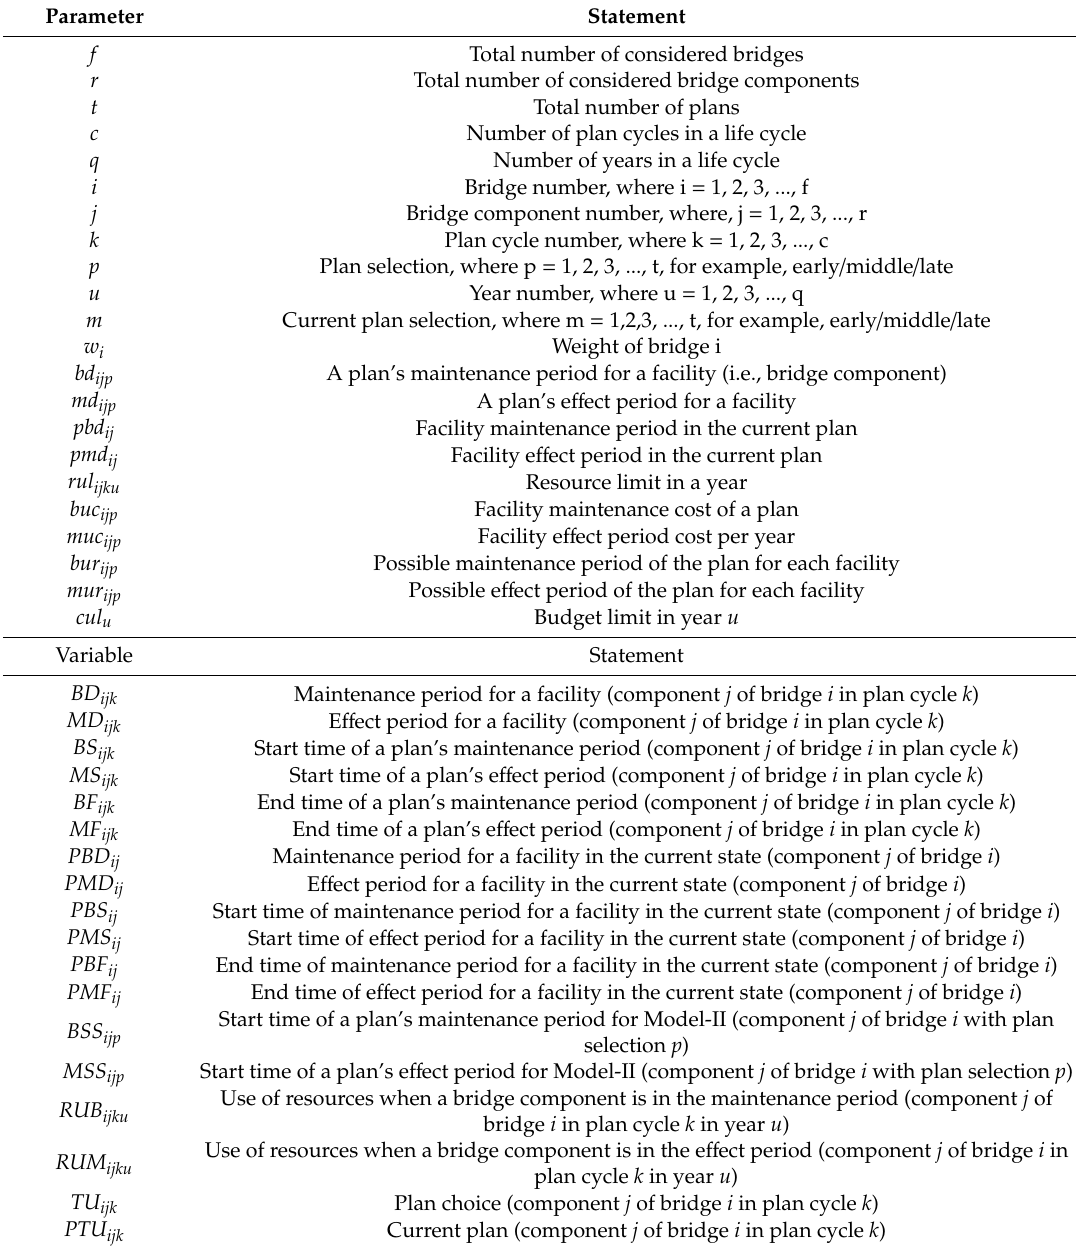
Table 4. Model parameters and